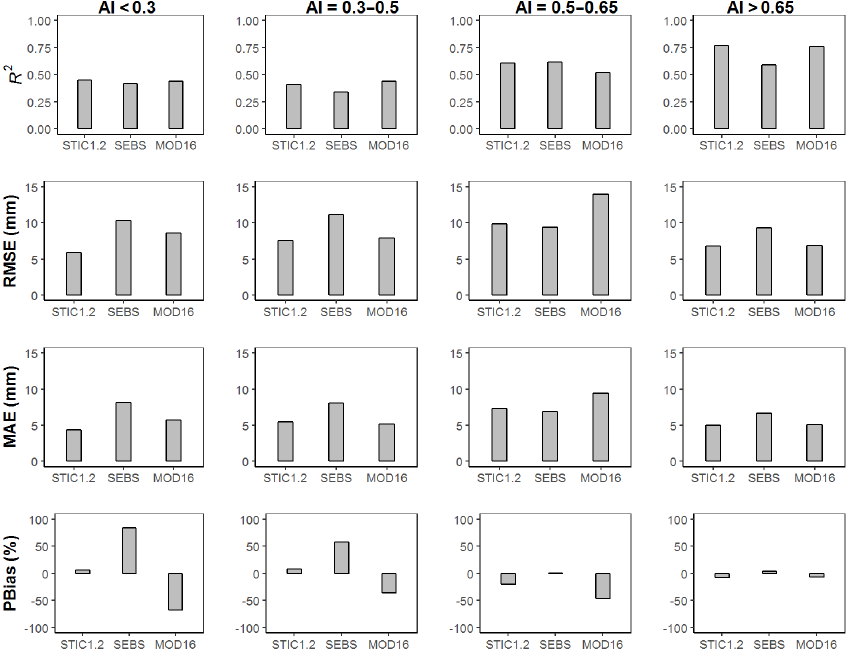
Figure 6. Evaluation of 8-day cumulative ET from STIC1.2, SEBS, and MOD16 for each long-term aridity index (AI) category.